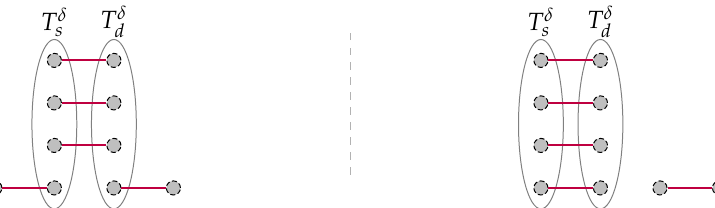
Figure 5. The two possible cluster repartitions in Case 1.1 with respect to T δ s and T δ thus at most five clusters. Ellipses separate